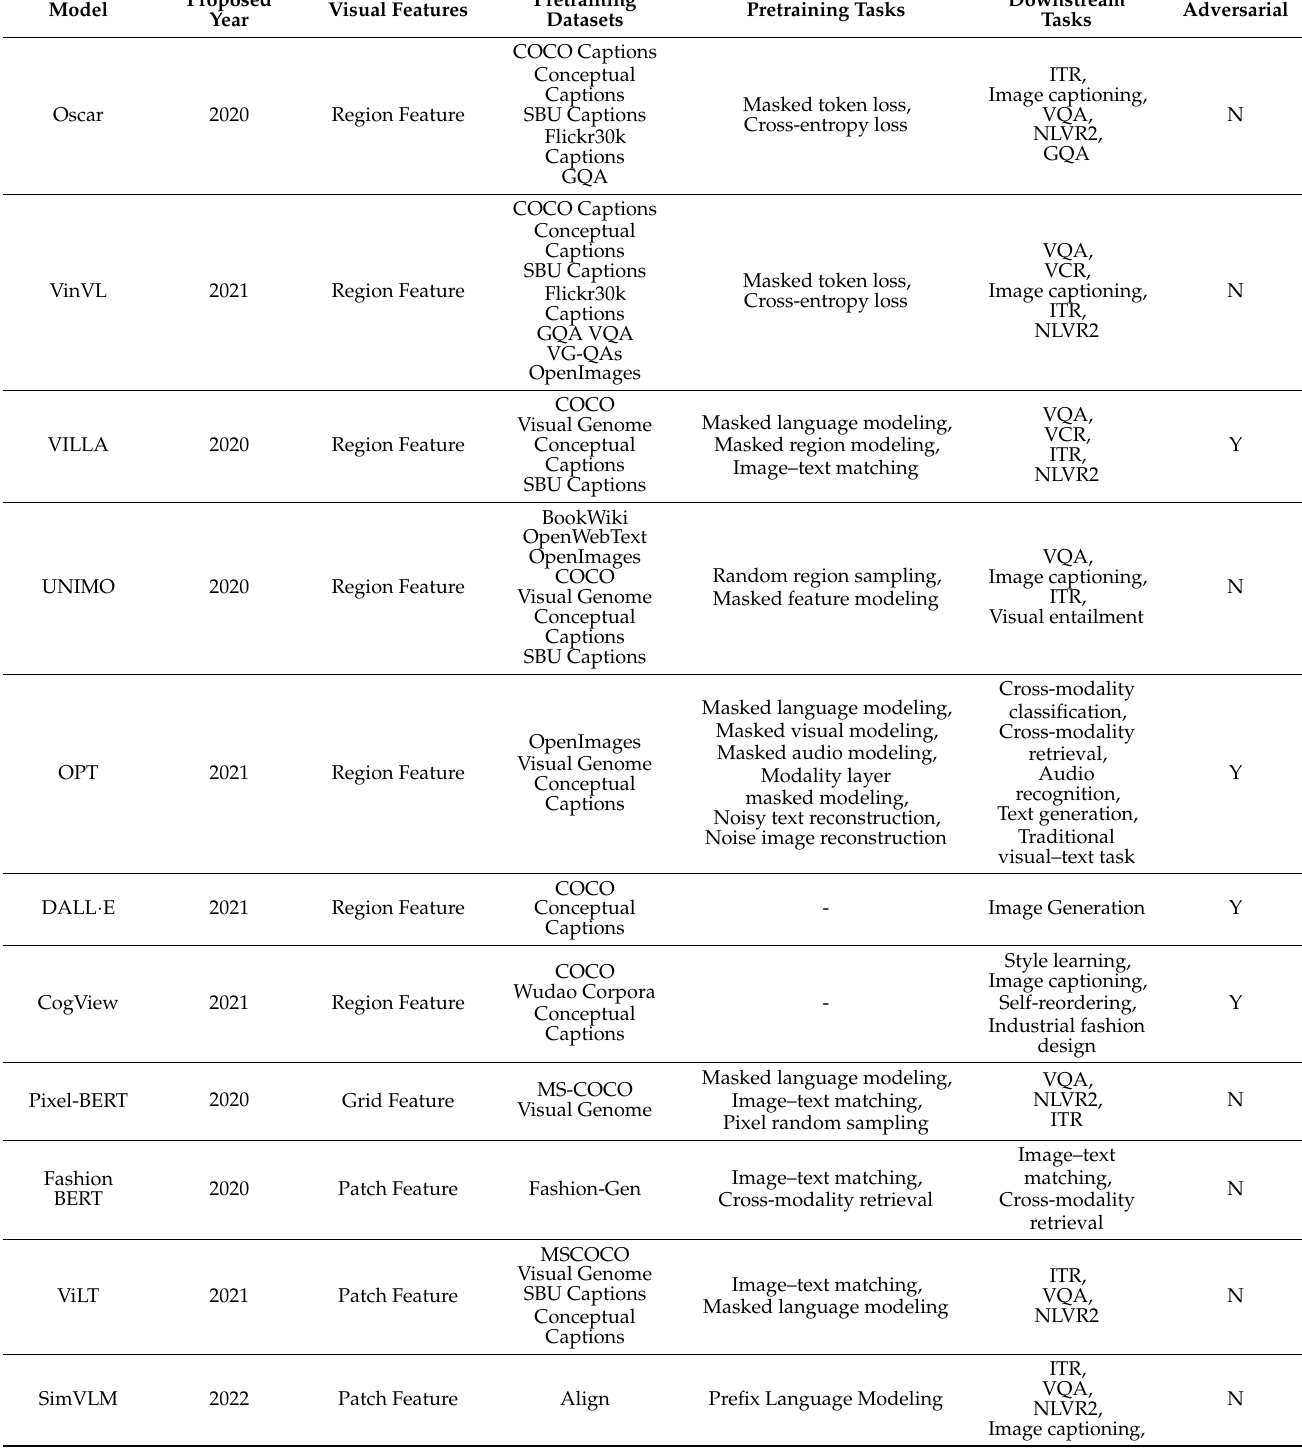
Table 5 summarizes the comparison of each single-stream architecture image–language pretraining model in the dimensions of pretraining tasks and downstream tasks. Table 6 shows the comparison of results of single-stream image–language pretraining models on some public datasets. The evaluation results presented in this paper all come from these related works. Table 5. Comparison of image–language pretraining models in single-stream